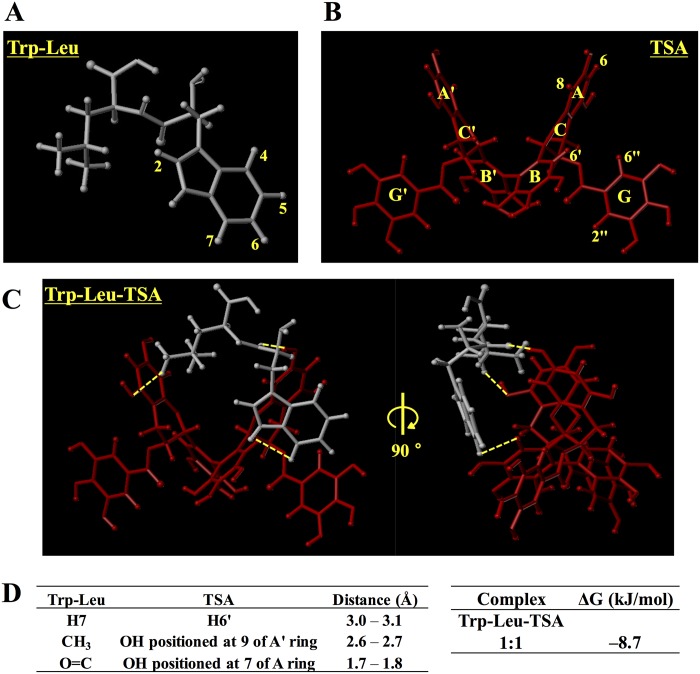
Conformations of Trp-Leu alone (A), TSA alone (B), and the 1:1 complex of Trp-Leu with TSA (C).The interactions between both molecules are indicated by the yellow dotted line. Distance (Å) between Trp-Leu and TSA, and ΔG (kJ/mol) of the complex are summarized in (D).